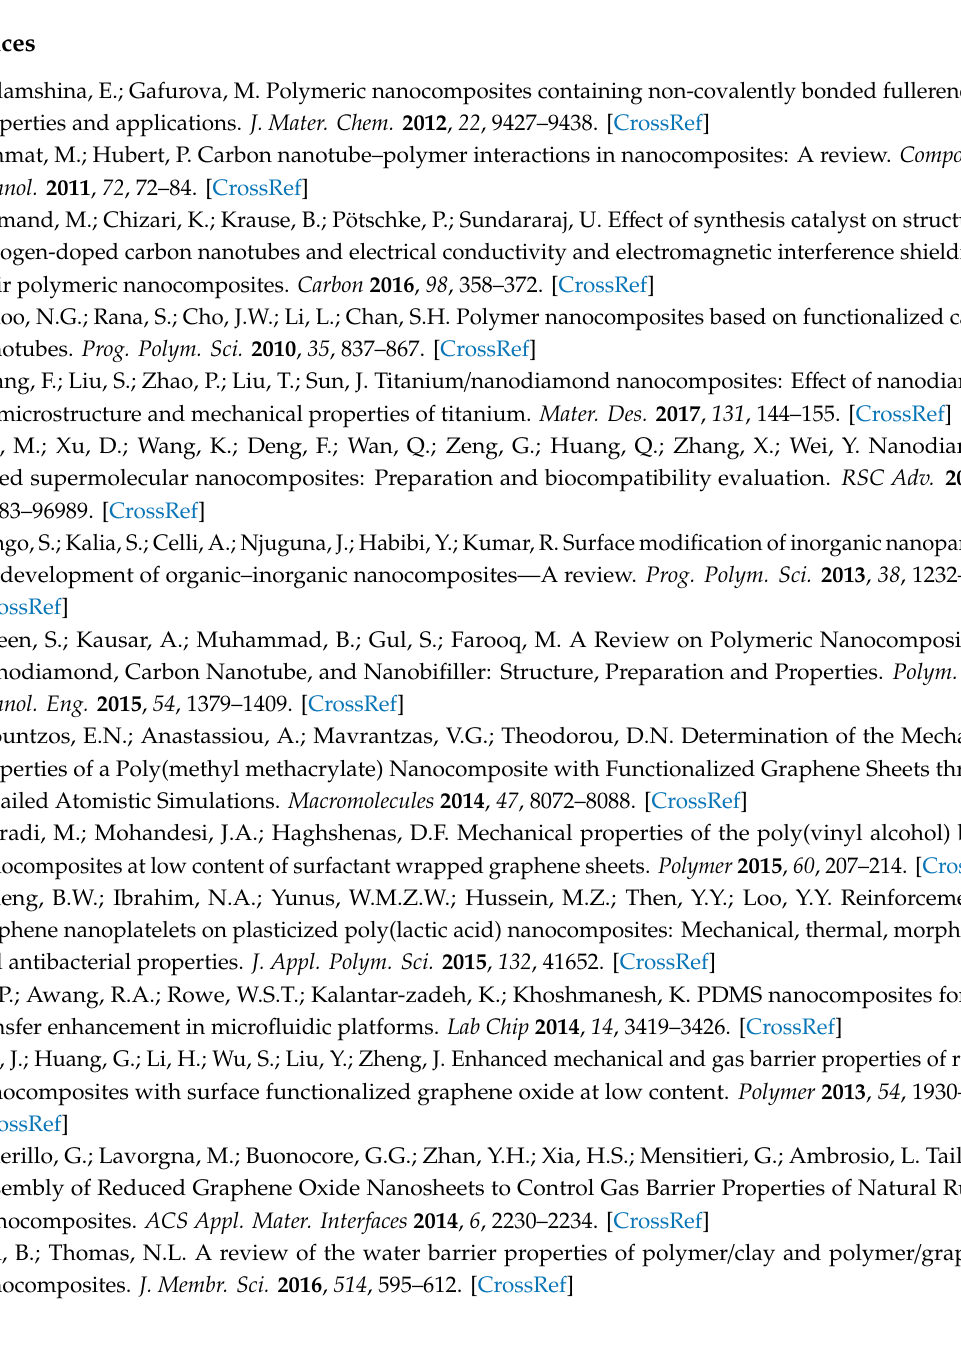
sponges. Figure S7 Compressive stress-strain graph for determination of compressive modulus of PDMS sponges and PDMS / rND composite sponges. Figure S8 Zoom in of FTIR spectra (main Manuscript, Figure 4), signifying change in absorption bands 1780 and 1628 cm-1. Figure S9 Separation of a para ffi n oil / water emulsion in three steps with a PDMS / rND composite (0.025 wt % rND) sponges. Figure S10. Microscopy images of the oil (para ffi